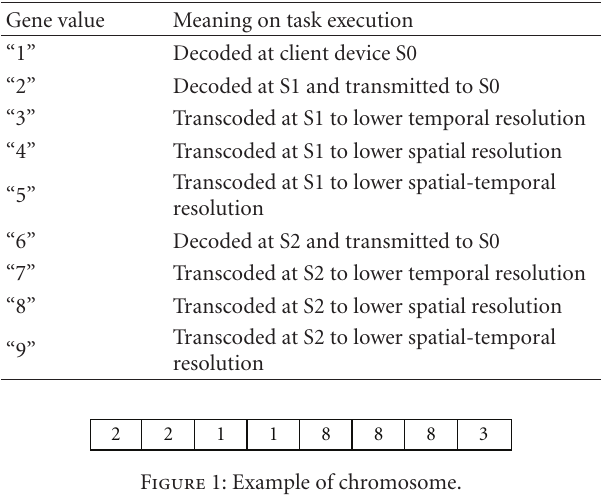
Table 2: Description of genes.